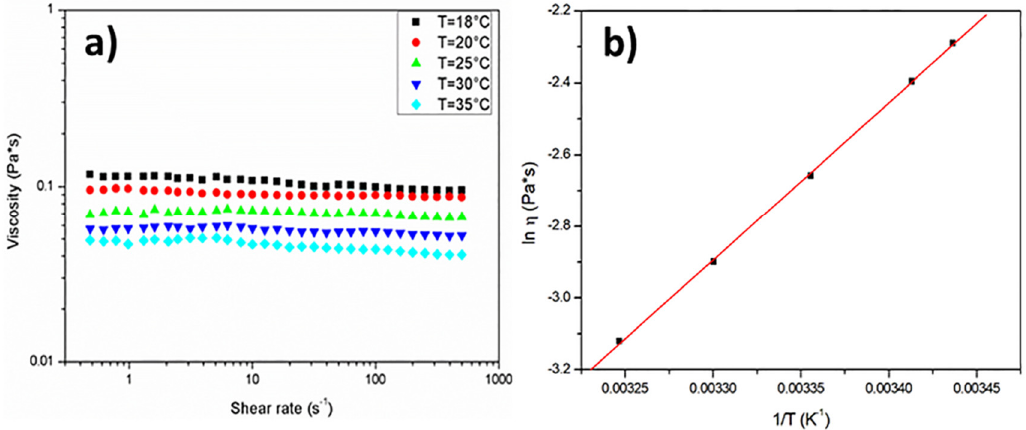
Figure 3. ( a ) Effect of the shear rate on the viscosity of the test fluid at different temperatures; ( b ) temperature dependence of the viscosity of the test fluid.